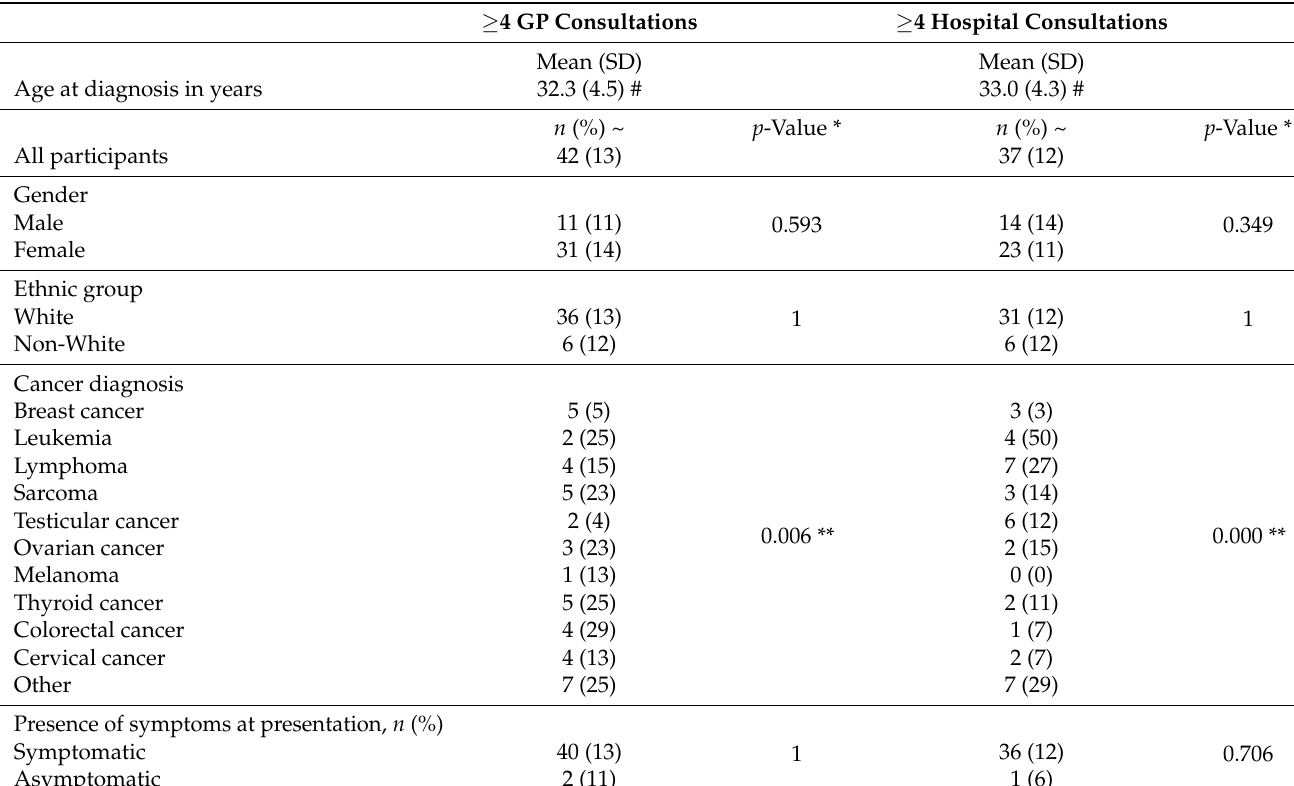
Table 3. Participant characteristics with 4 or more pre-diagnosis